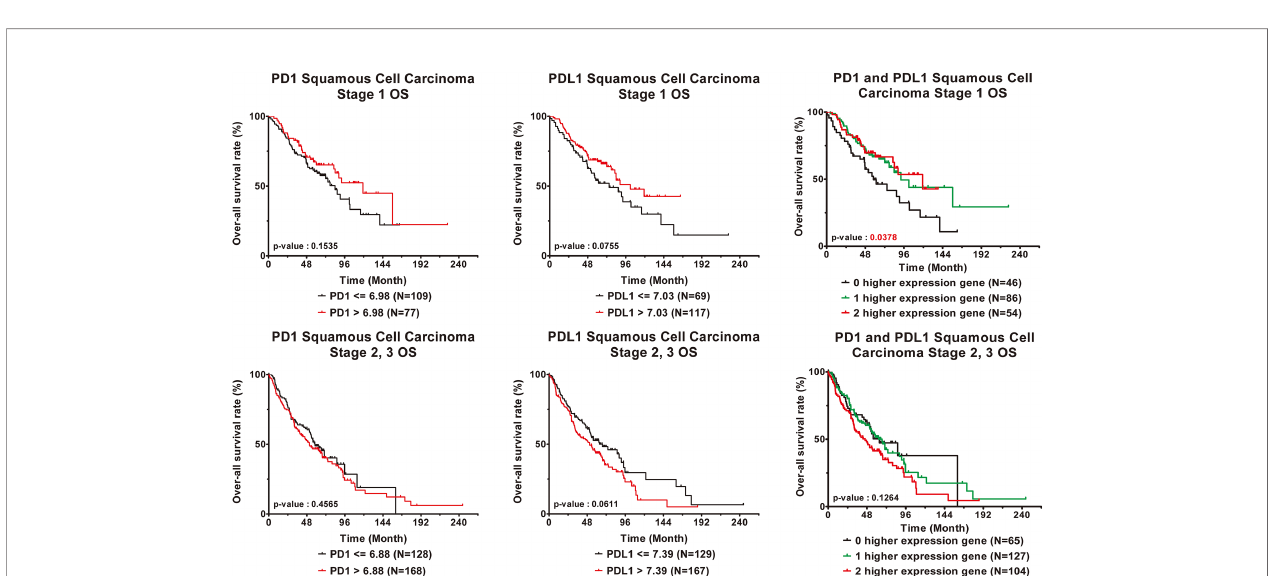
FIGURE 4 | Clinical outcome interacted with expression levels of PD1 or PDL1 in squamous cell carcinoma lung cancer patients. Kaplan-Meier statistical analyses were conducted to examine the association between over-all survival and the expression of PD1 and PDL1 and the number of higher expressed genes in early stage (top) and late stage (bottom) squamous cell carcinoma lung cancer